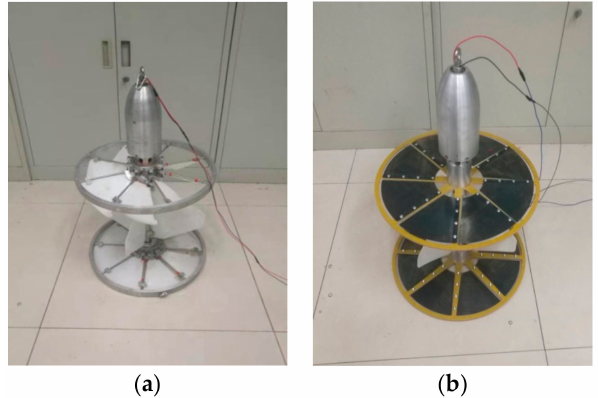
Figure 2. Physical prototype of the novel WEC: ( a ) Rigid blade WEC; ( b ) Flexible blade